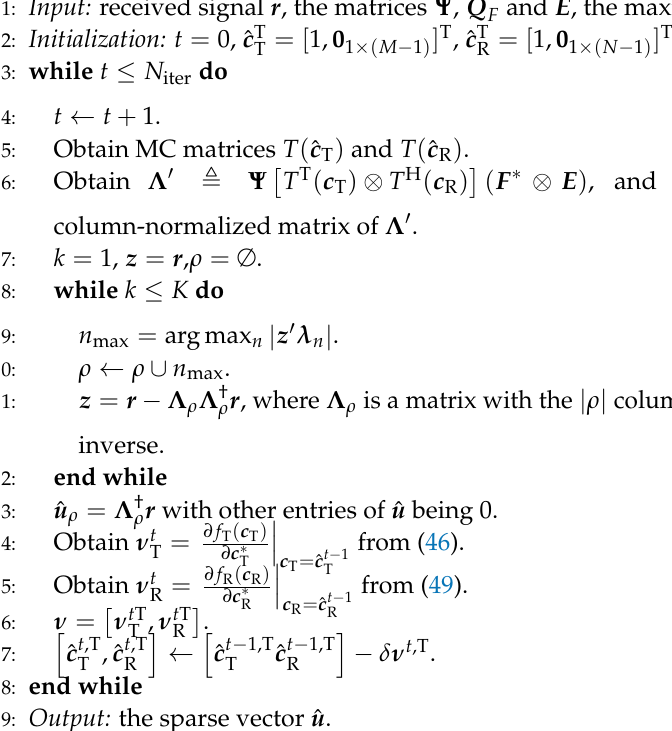
Algorithm 1 Channel estimation with MC